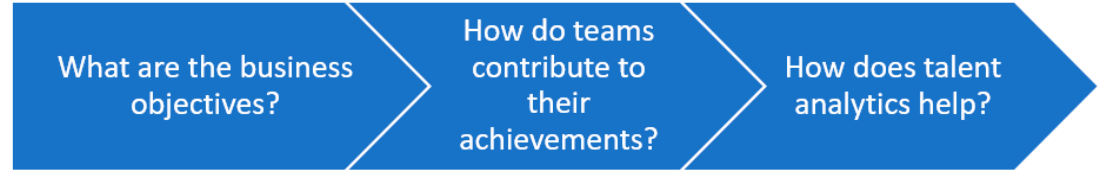
Figure 1. From strategy to talent analytics. Note: Adapted from Levenson (2015).